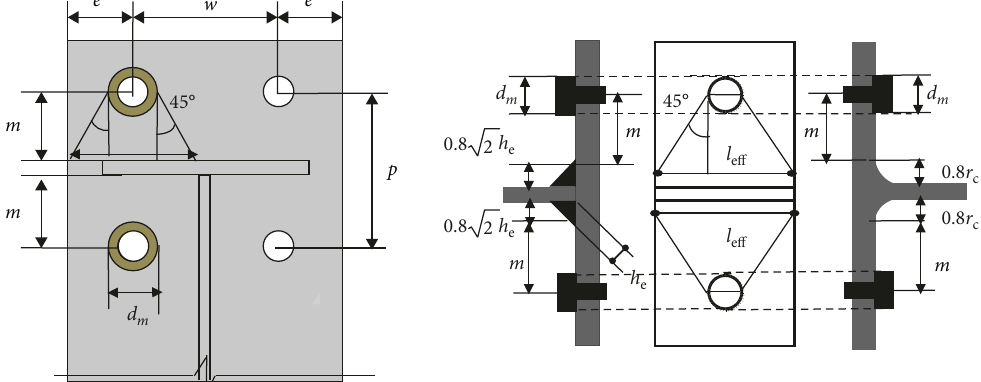
Figure 12: Calculation sketch of l